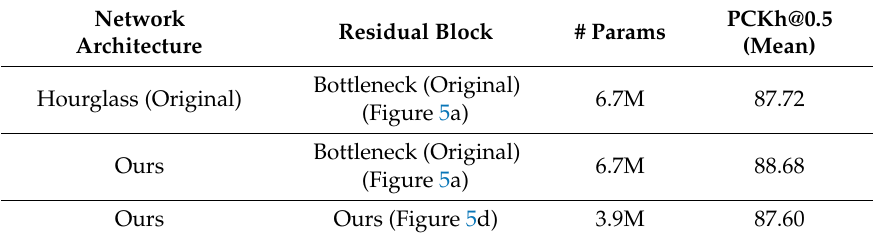
Table 3. Comparison of di ff erent network architectures with the MPII validation dataset. (# Params is the total number of parameters in a dual-stack hourglass network).